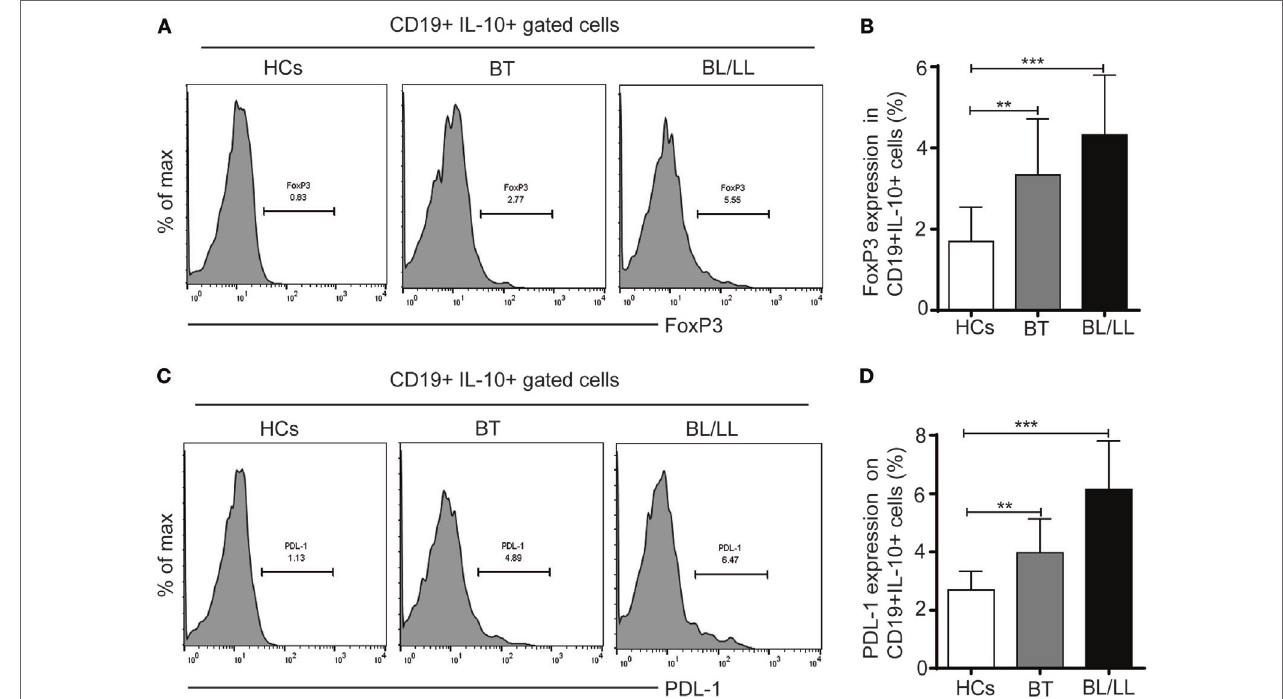
FigUre 2 | FoxP3 and PDL-1 expression in regulatory B cells (Bregs) (CD19 + IL-10 + ). (a) Representative histogram showing expression of FoxP3 in Breg (CD19 + IL-10 + ) cells in peripheral blood mononuclear cells (PBMCs) isolated from peripheral blood of HCs ( n = 10), borderline tuberculoid (BT), and BL/LL patient ( n = 25). (B) Graph plot is showing expression of FoxP3 in HCs and leprosy patients (BT, BL/LL). (c) Representative histogram showing expression of inhibitory molecule receptor (PDL-1) on Breg (CD19 + IL-10 + ) cells in PBMCs isolated from peripheral blood of HCs, BT, and BL/LL patient. (D) Graph plot is showing expression of PDL-1 on HCs and leprosy patients (BT, BL/LL). Mean ± SD values are shown in each set while p value < 0.05 was considered significant. 100,000 cells were acquired and analyzed by flow cytometry. Data analysis was performed with flowjo software. Statistical analysis was done using Student’s t -test for unpaired samples (* p < 0.05; ** p < 0.005; *** p <